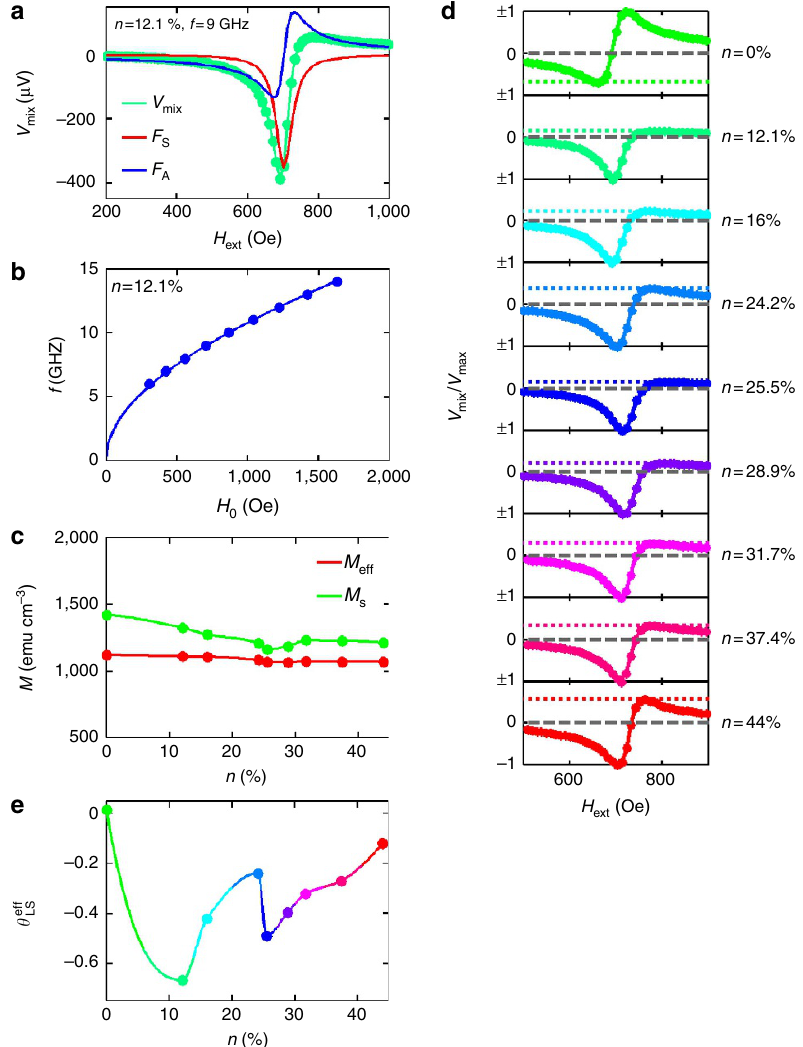
Figure 2 | Line-shape analysis. ( a ) V mix along with the fitted (green), symmetric ( F S , red) and asymmetric ( F A , blue) Lorentzian functions used for the fitting for n ¼ 12.1% ( Q ¼ 0.3%). ( b ) Frequency as a function of the resonant field for n ¼ 12.1% ( Q ¼ 0.3%) used in the Kittel formula fitting. ( c ) The magnetization M S determined by VSM and effective demagnetization field M eff from the Kittel formula fitting versus oxygen concentration n . ( d ) V mix normalized to either its minimum or maximum value for different oxygen concentrations at 9GHz. The coloured dotted line denotes the corresponding maximum/minimum value of V mix . The dotted line (dashed grey line) indicates the zero level. ( e ) SHA calculated from the line-shape analysis y eff function of the oxygen concentration n